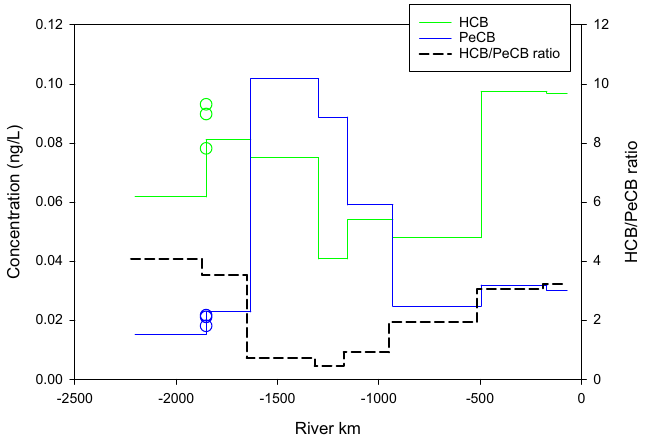
Figure 3. Spatial variation in freely dissolved aqueous HCB and PeCB concentrations and in HCB/PeCB concentration ratio observed from the source of the Danube river to its mouth (km 0) during the Joint Danube Survey 3 (13.08.2013–25.09.2013). Note that the profile for the HCB/PeCB ratio was shifted to the right for a visual